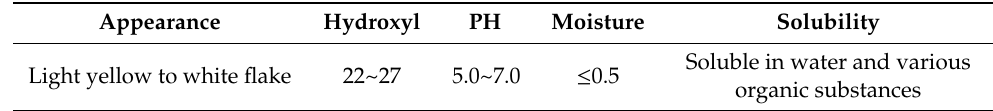
Table 5. Technical parameters of superplasticizer.